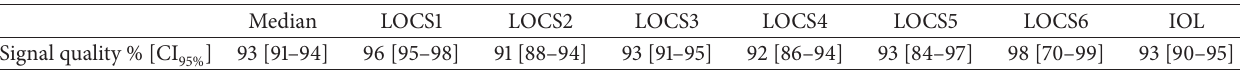
Table 4: The signal quality of the eye tracker device stratified per LOCS III